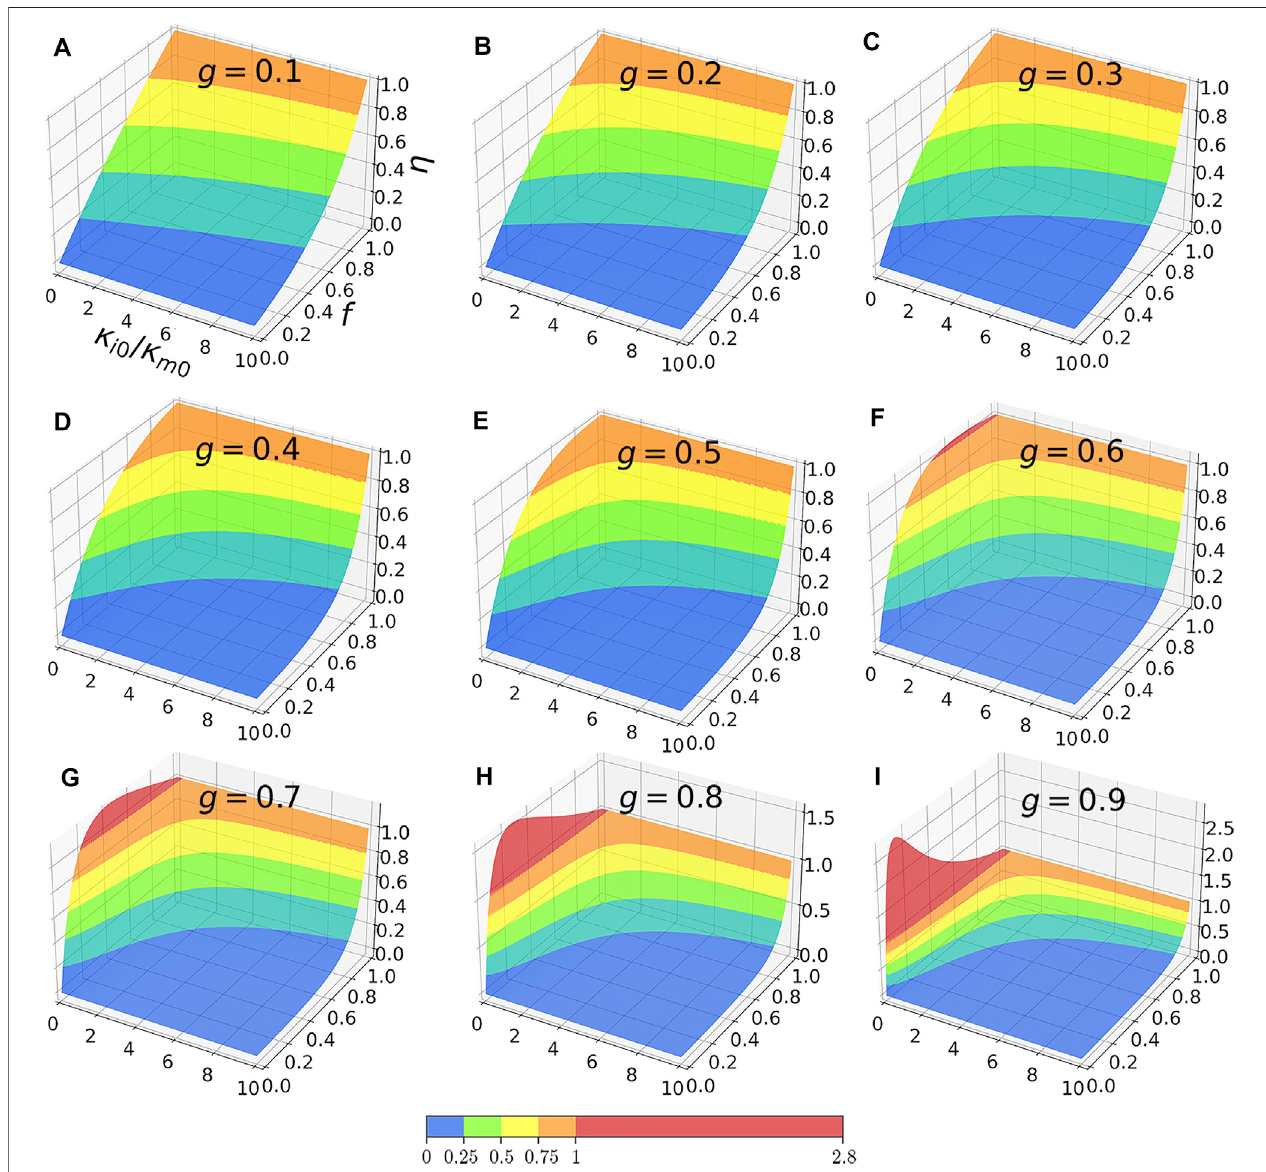
FIGURE 2 | Values of η for nonlinear inclusions and linear matrix. Each subplot shows how η varies with f and κ i 0 / κ m 0 given a different value of g from 0.1 to 0.9. In particular, the surface when η > 1 is plotted in red.